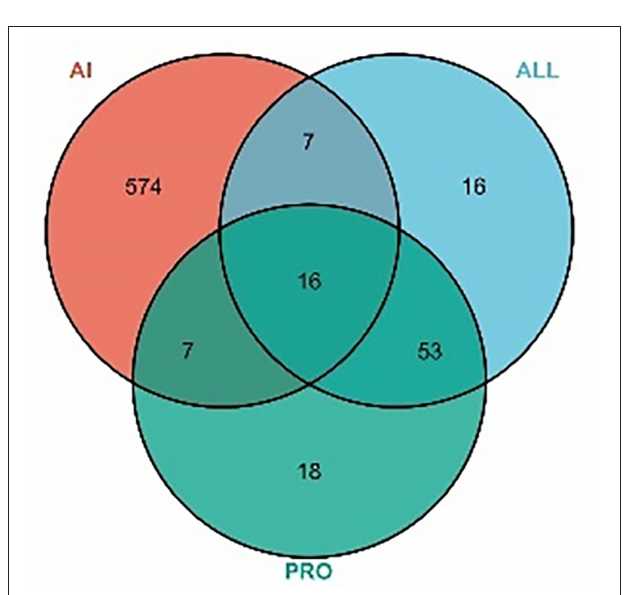
FIGURE 4 | VENN diagram for MPTA and AI. Number of potential targets of MPTA against acute inflammation (AI). ALL, number of potential targets predicted for allocryptopine; PRO, number of potential targets predicted for protopine; AI, number of target genes for acute inflammation screened from the disease